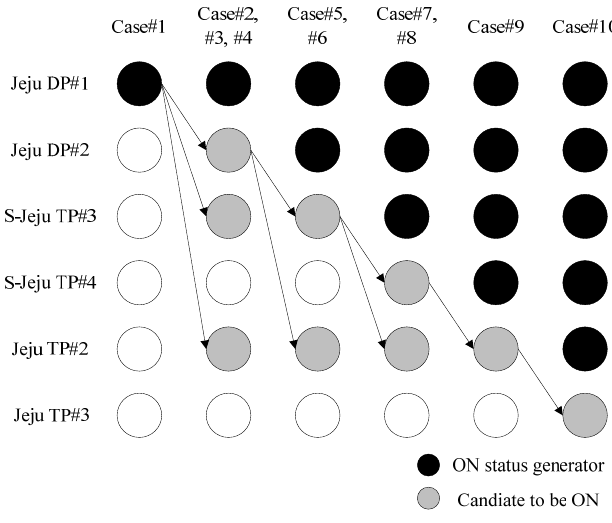
Figure 5. Jeju Island generation scenarios.